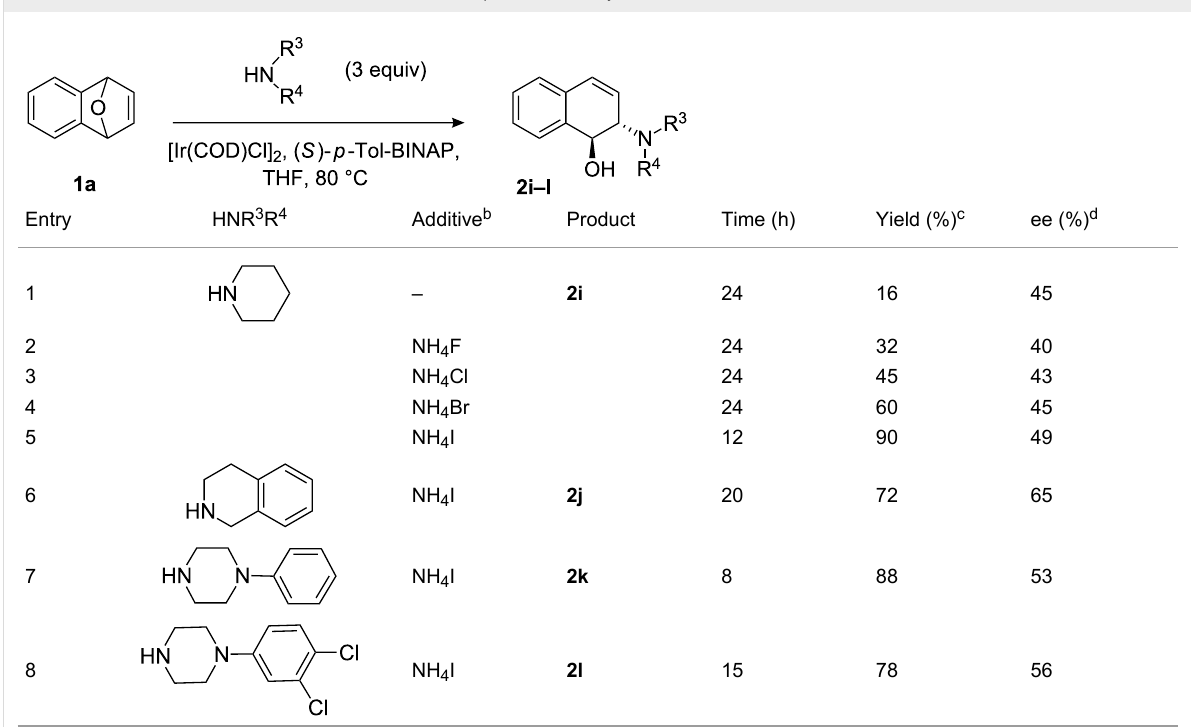
Table 3: ARO of oxabenzonorbornadiene 1a with various aliphatic secondary amines. a